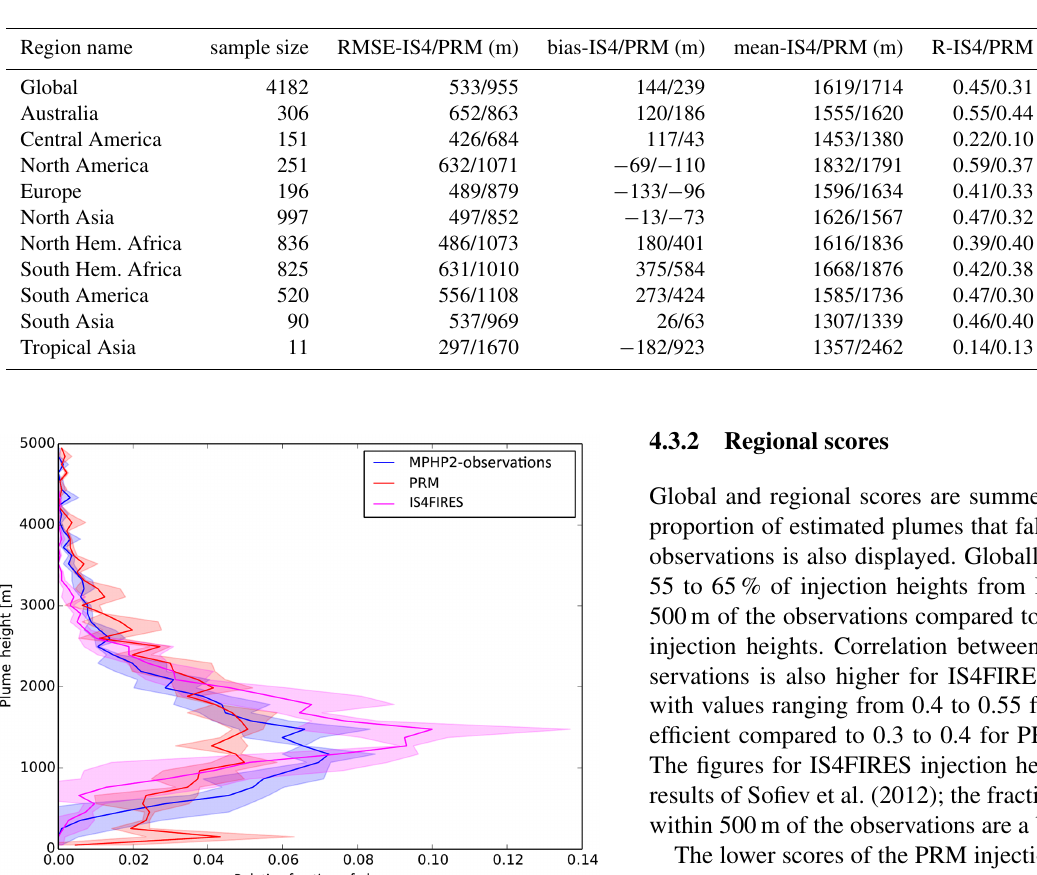
Table 2. Scores of IS4FIRES/PRM plume height against the MPHP2 data set for the year 2008, for each region defined in Fig. 1. The “% inside” score corresponds to the relative fraction of estimated plumes that are within 500m of the MPHP2 observations.